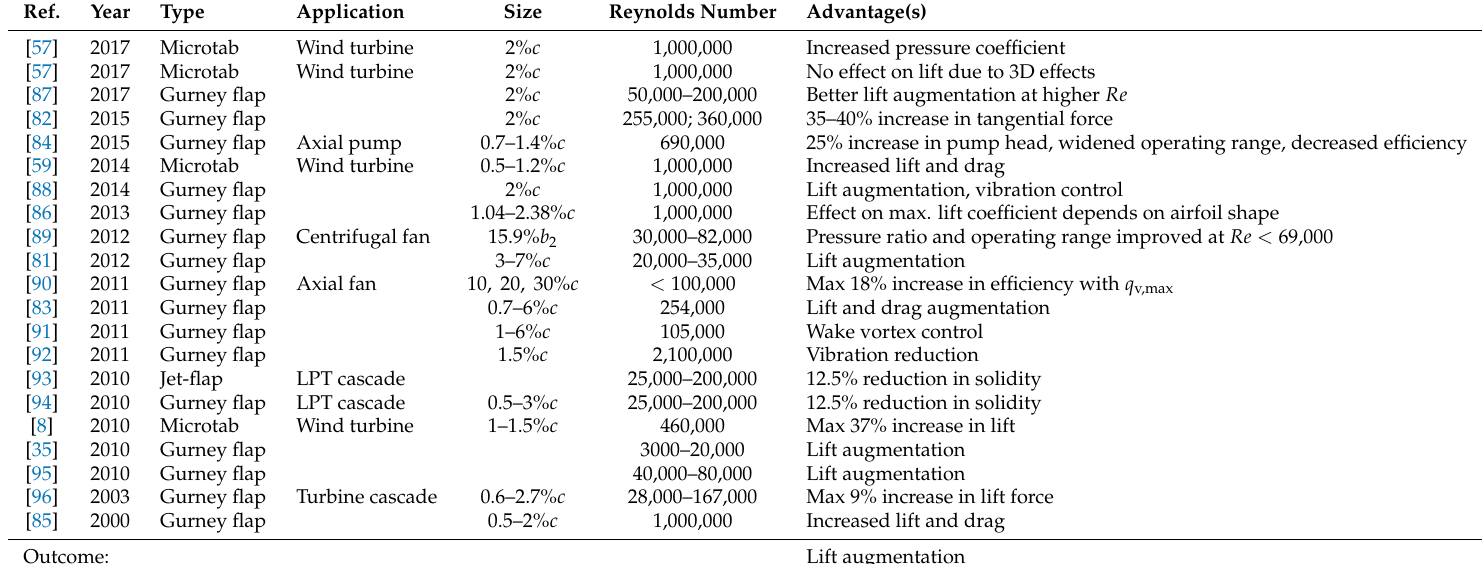
Table 6. Representative summary of Gurney flap